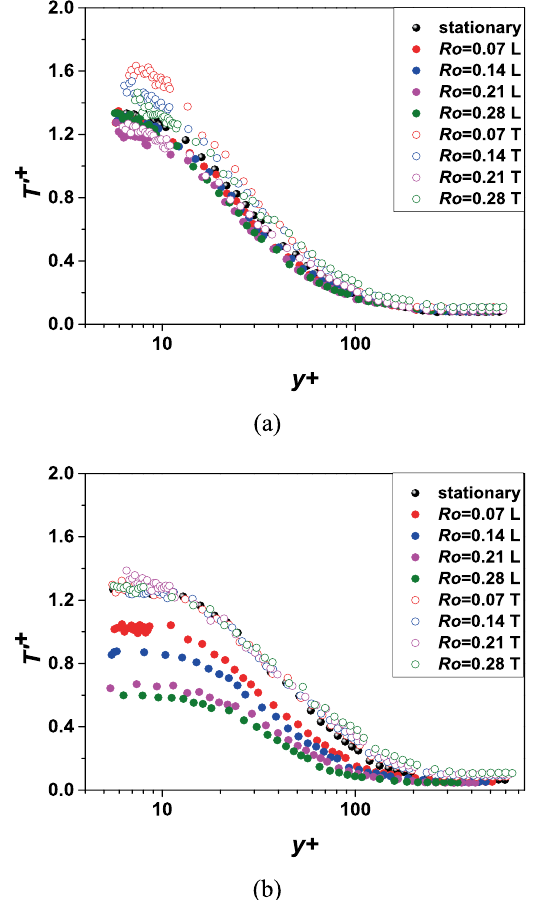
Figure 9. Fluctuating temperature statistics under different Ro and x/D . ( a ) location 0; ( b ) location